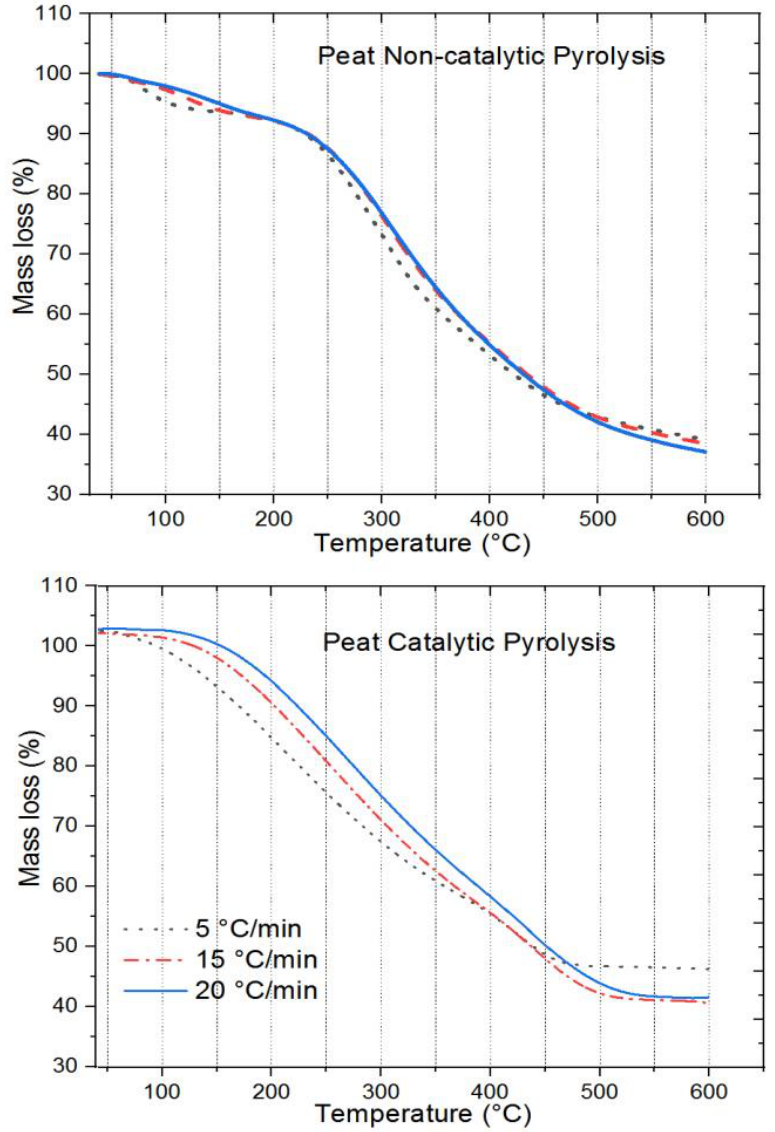
Figure 1. Thermogravimetric curves of the non-catalytic and catalytic processes of peat pyrolysis.